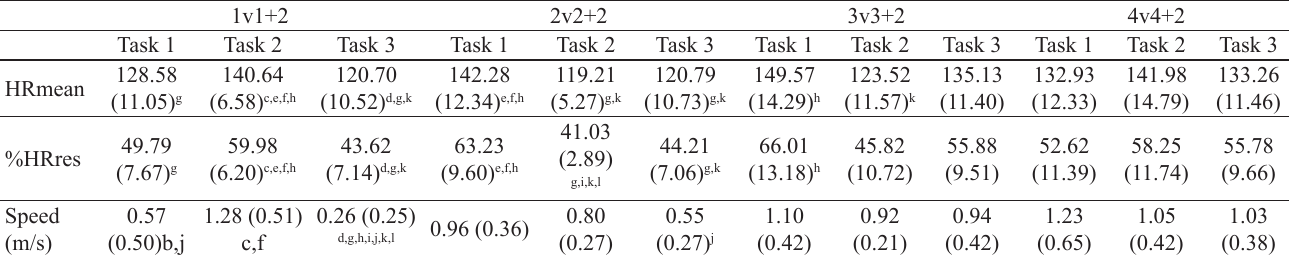
3. Descriptive table (mean and standard deviation) and statistical comparison between crossing factors (game